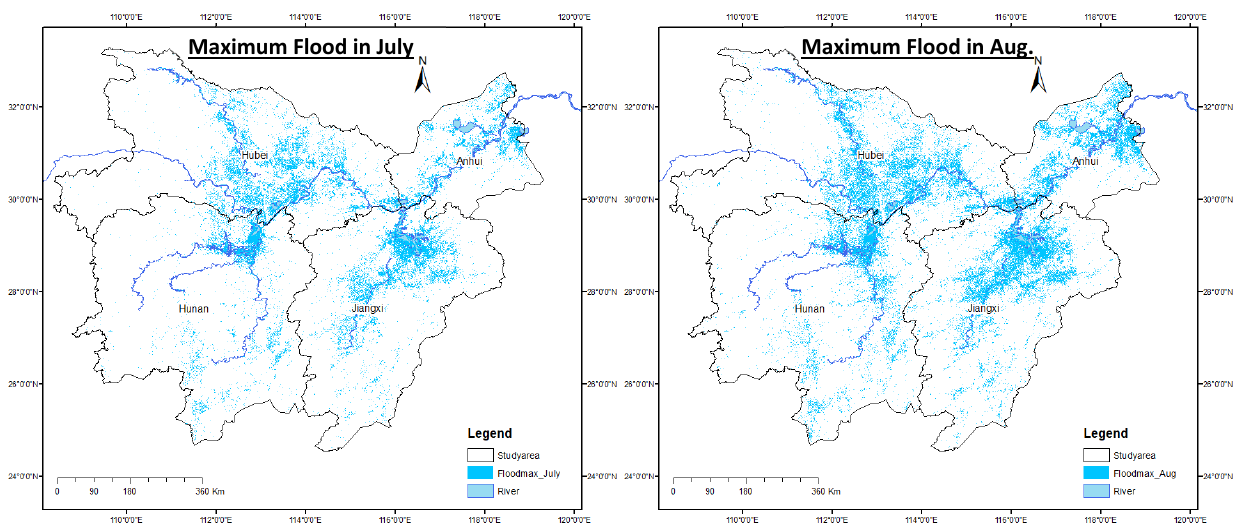
Figure 10. Monthly flooding map in July and August 2020.